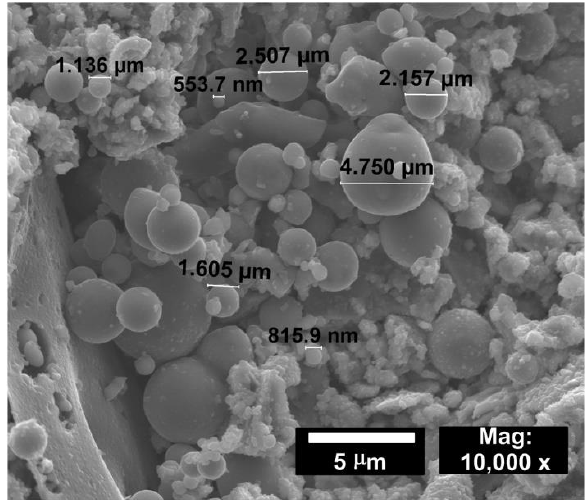
Energies 2020 , 13 , x FOR PEER REVIEW 14 of 20 Figure 8. A view of fine fly ash particles used in the studies. Figure 8. A view of fine fly ash particles used in the studies.